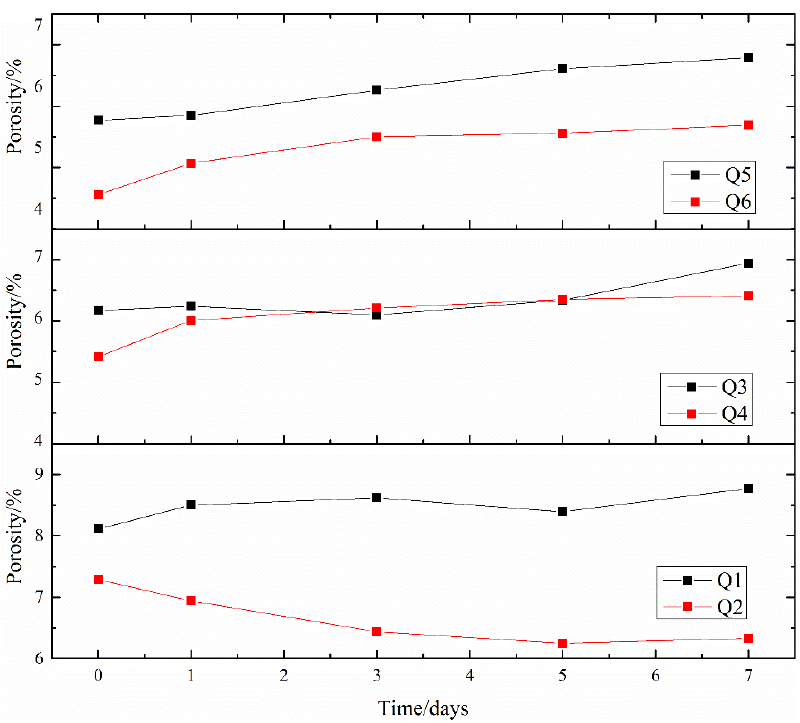
Figure 8. Porosity analysis of shale core samples during CO 2 treatment.